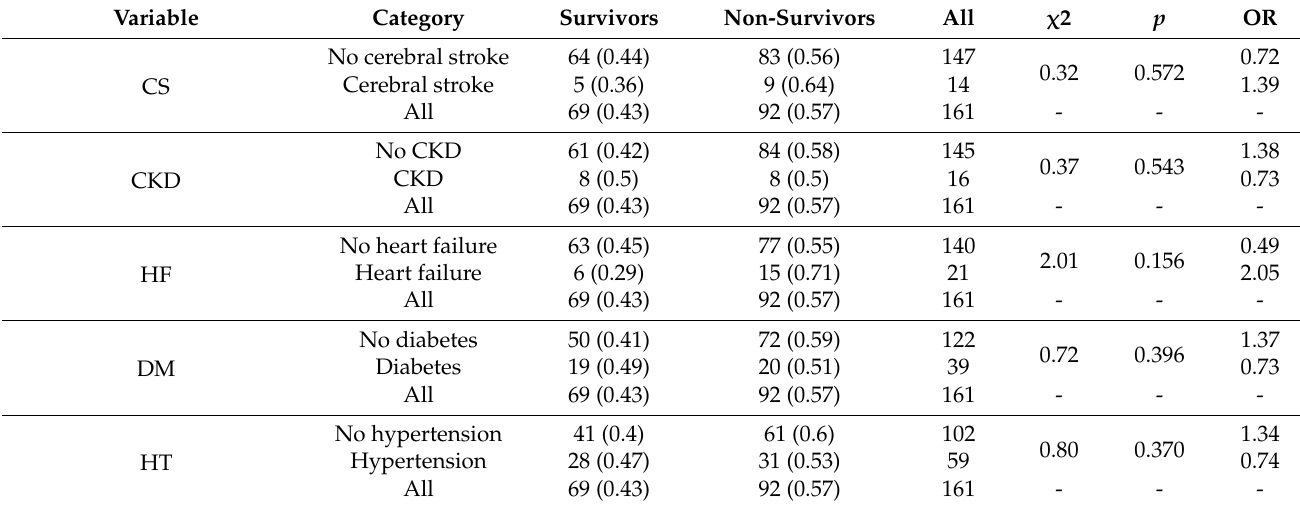
The counts of individual strata are shown as observed count (% from table rows). Columns and rows labeled “All” refer to sums of counts from particular columns and labels of the contingency tables. Abbreviations: OR, odds ratio; ACS, acute coronary syndrome; HF, heart failure; DM, diabetes mellitus; CKD, chronic kidney disease; CS, cerebral stroke; HT, hypertension; OHCA, out-of-hospital cardiac arrest; IHCA, in-hospital cardiac arrest; PEA,